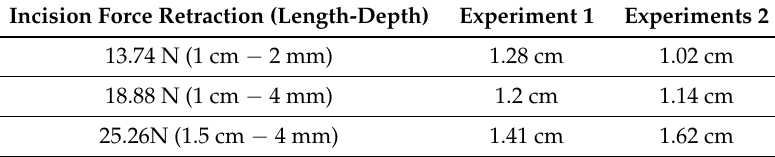
Table 8. Variables related to the experimental forces measured.